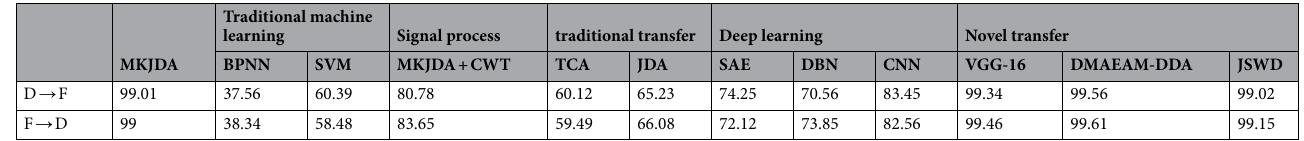
Table 3. Comparative results between different methods ( F